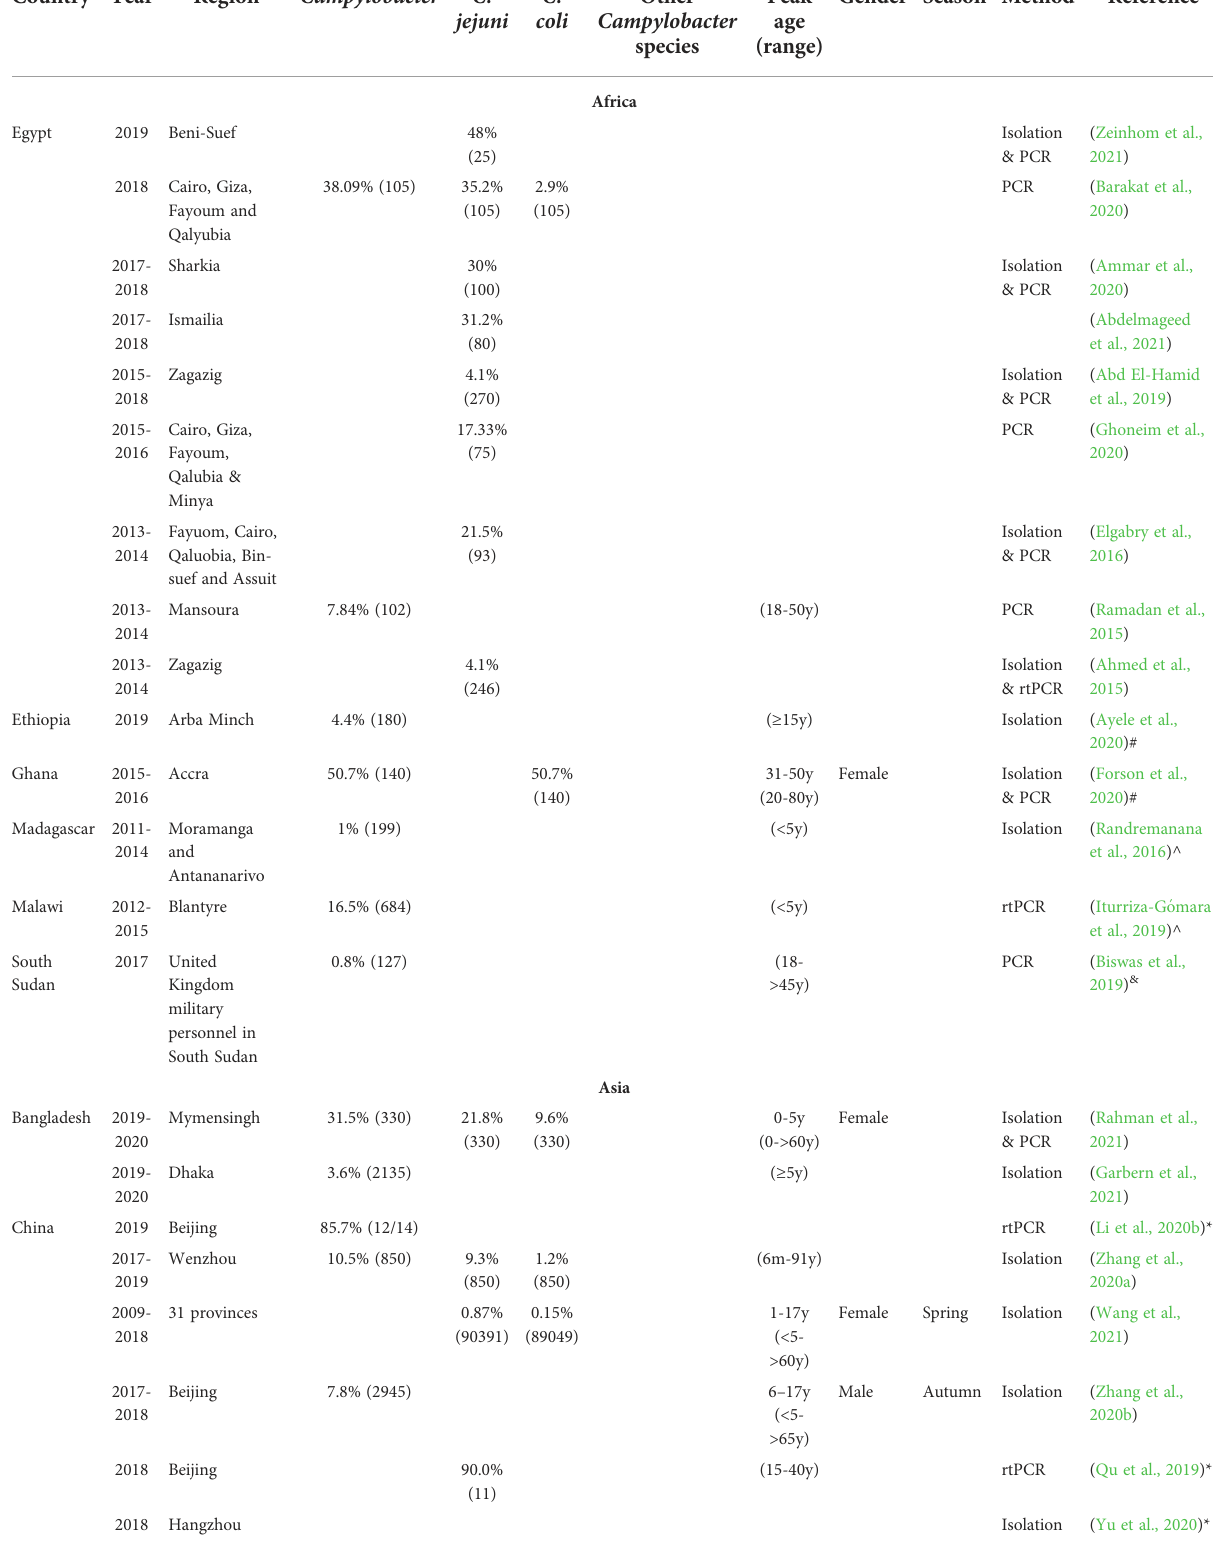
TABLE 2 Campylobacter infection in countries without national surveillance